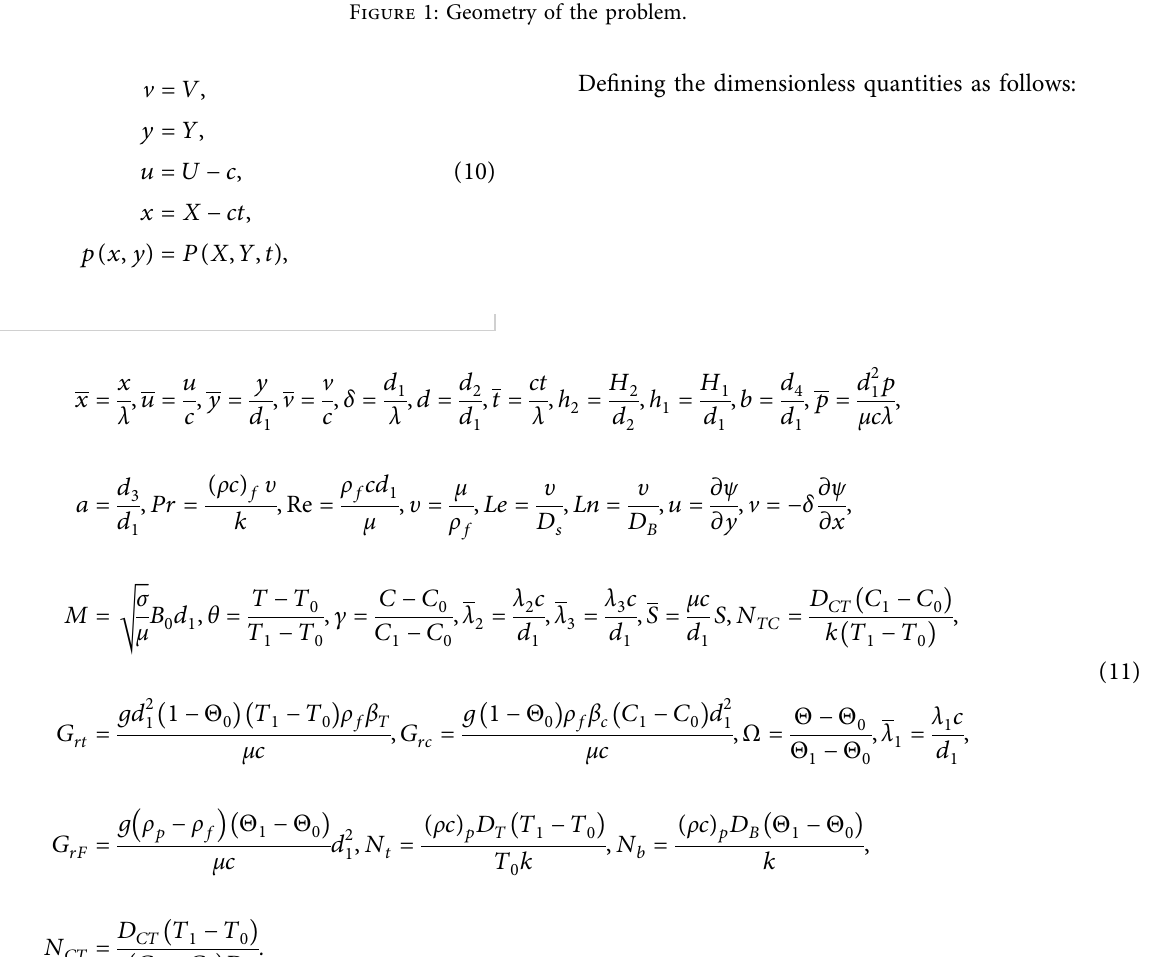
Figure 1: Geometry of the